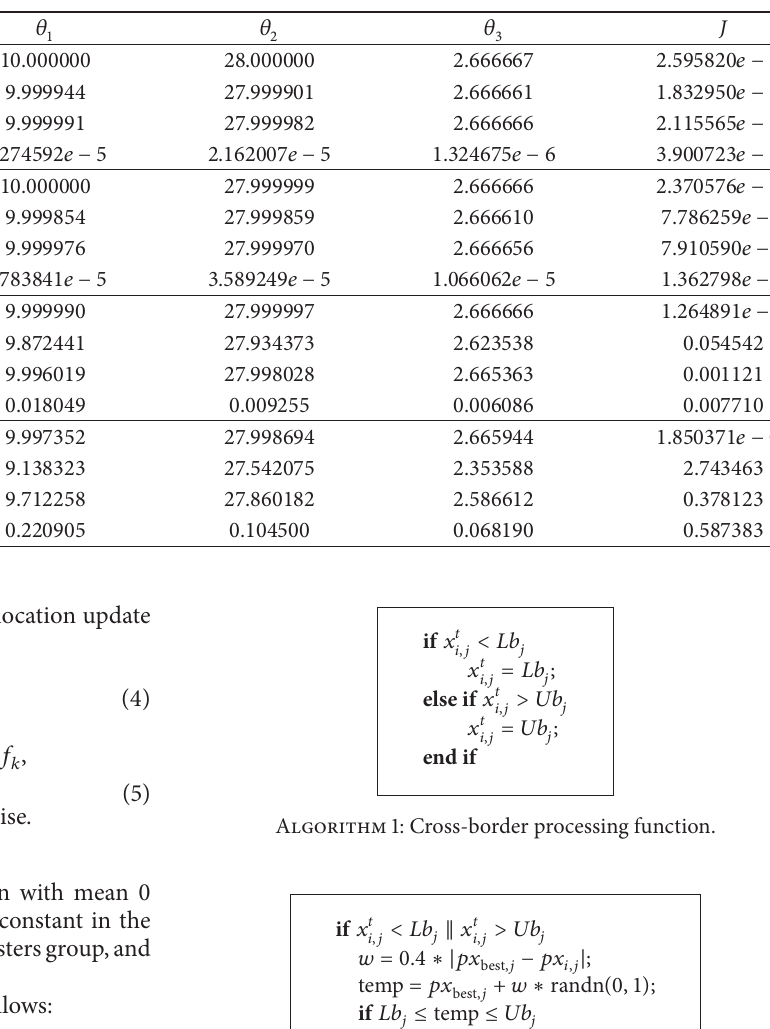
Table 1: Estimation results for different time series L .